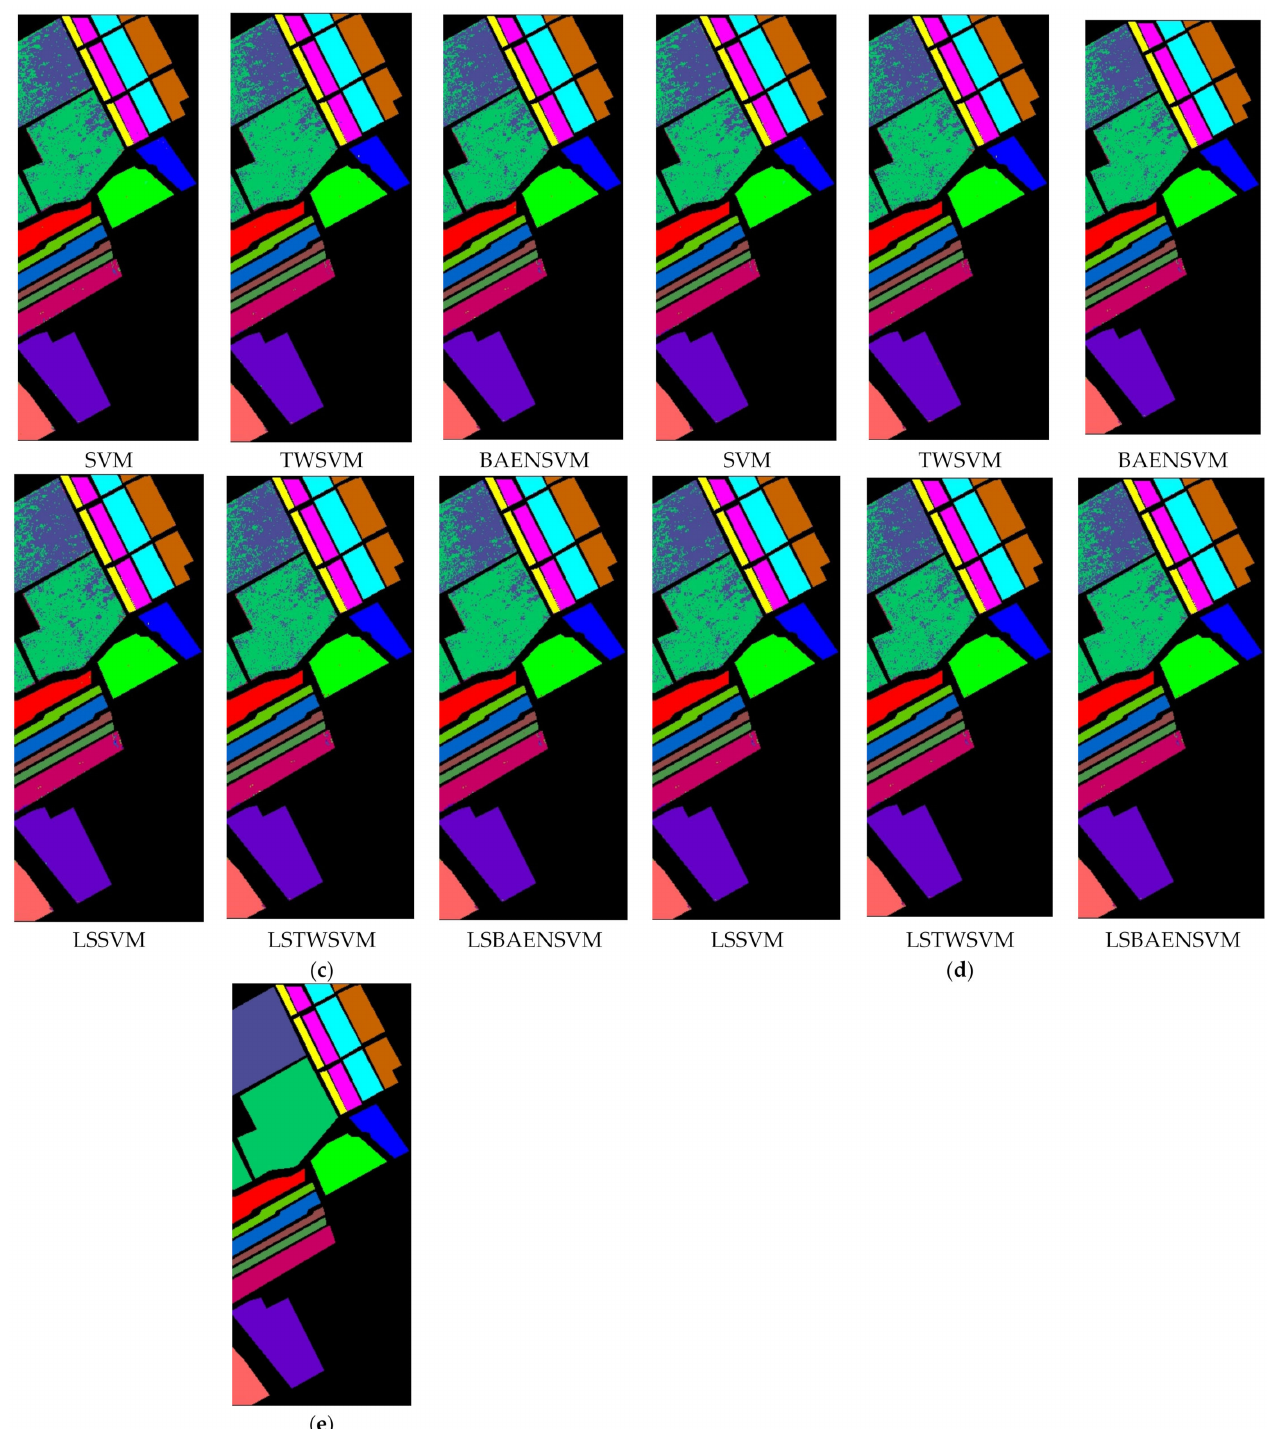
Figure 12. Salinas hyperspectral image classification result images. ( a ) Training Dataset 1, ( b ) training Dataset 2, ( c ) training Dataset 3, ( d ) training Dataset 4, ( e ) ground